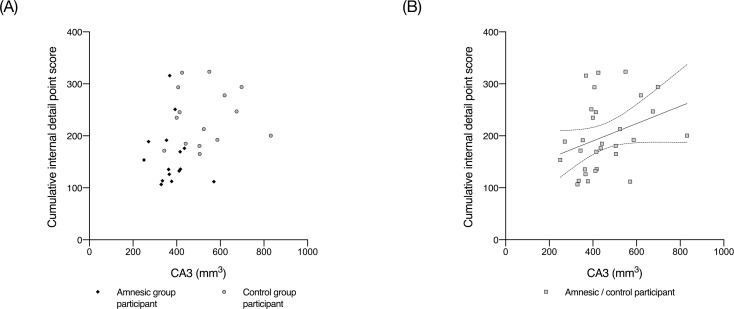
Scatterplots of CA3 volume against total internal detail.CA3 volumes were normalized against the total intracranial volumes obtained from the VBM analyses and were collapsed across the left and right hippocampi because there was no significant interaction term between group (amnesic, control), side (left, right), and subfield (CA1, CA2, CA3, DG, and SUB) (F(2.02,56.55) = 0.43, p=0.66; Figure 2). Insufficient contrast for delineation between the subfield boundaries on each coronal slice precluded the hippocampal subfield segmentation of one participant who was included in results from the AI. (A) At a single group level, the correlation between internal details and CA3 volume was not significant for the amnesic group (Kendall’s τ
(15) = −0.018, p=0.961, two-tailed) and for the control group (Kendall’s τ(15) = 0.43, p=0.458, two-tailed),possibly due to the small sample size and variability (15/group) (for individual data points: dark gray diamond = amnesic group participant; gray circle = control group participant); and, (B) significant association between total mean CA3 volume and total internal (episodic) detail, when these variables were collapsed across group (Kendall’s τ(30) = 0.287, p=0.026, two-tailed). The solid black line shows the best-fitting linear regression line and the dashed lines show 95% confidence intervals (β = 0.18, t = 2.05, p=0.049) (for individual data points: gray square = amnesic group or control group participant).